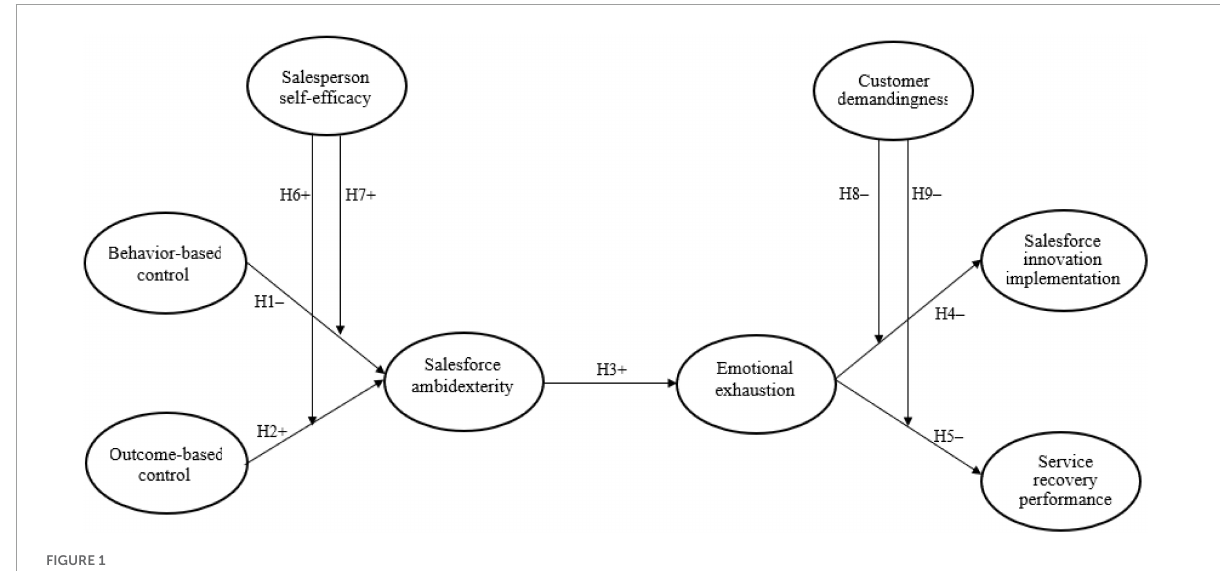
FIGURE1 Conceptual